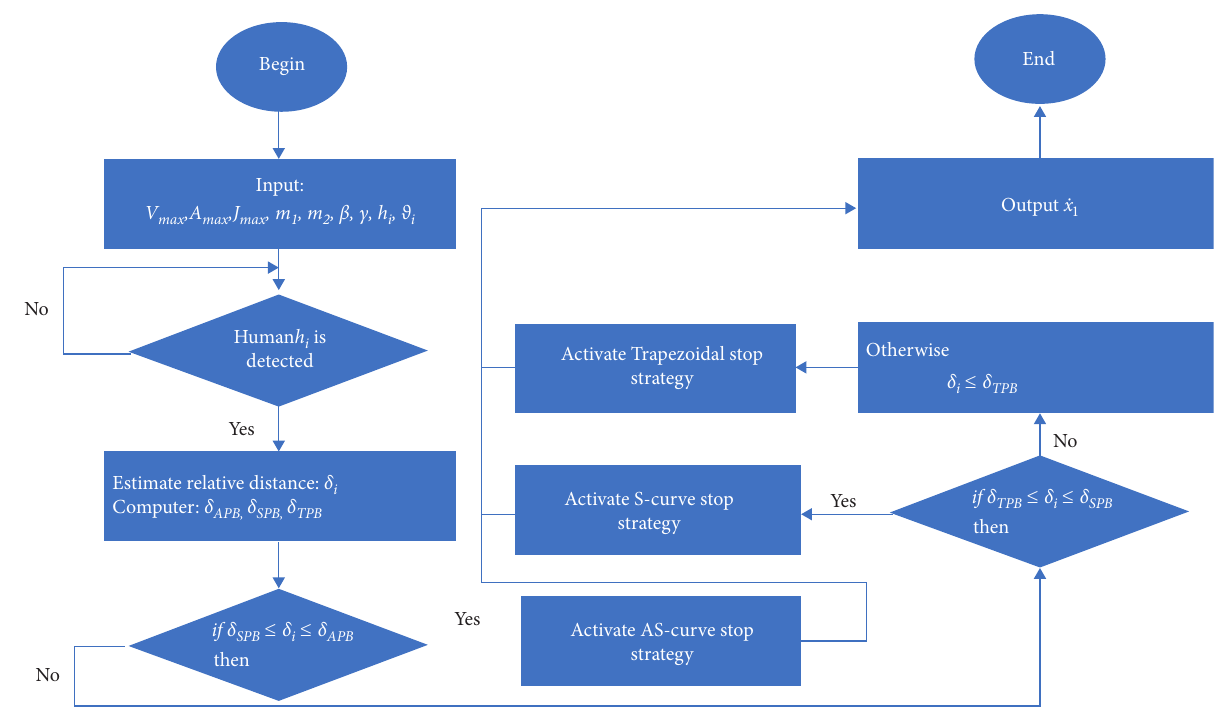
Figure 13: Description of the proposed switching mechanism for stop profile